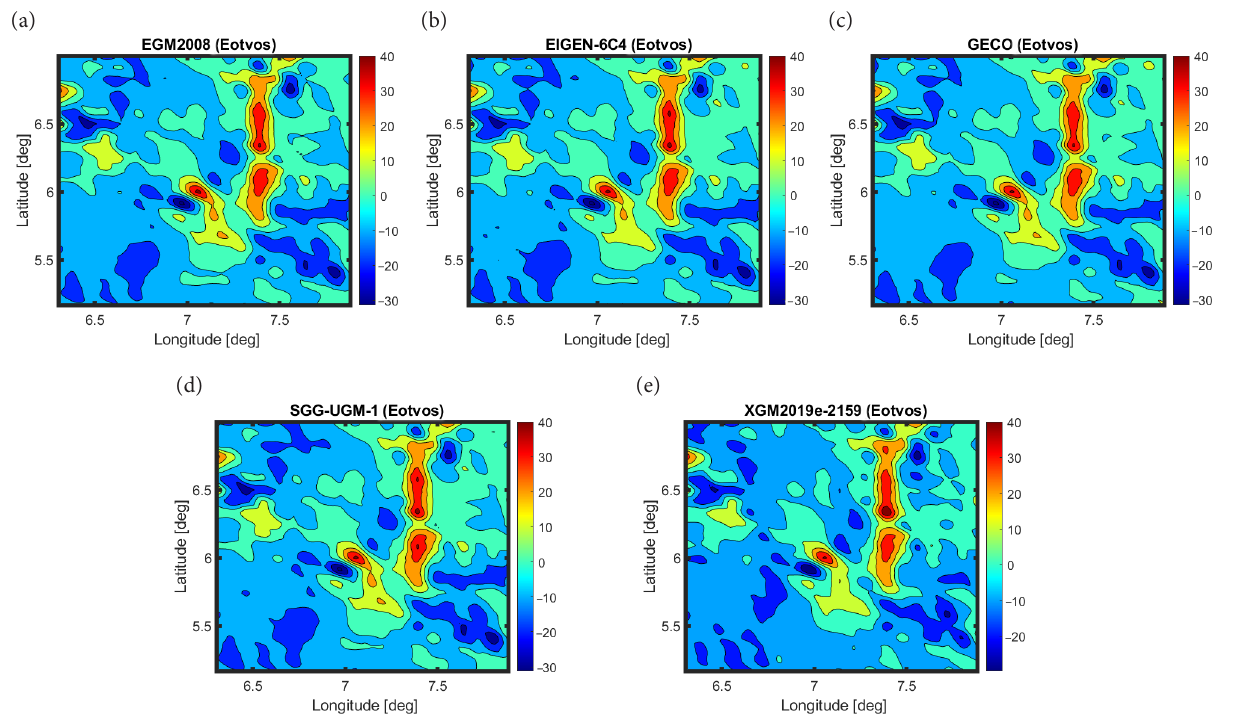
Figure 11. GGM-derived gravity gradient map of the Anambra Basin computed